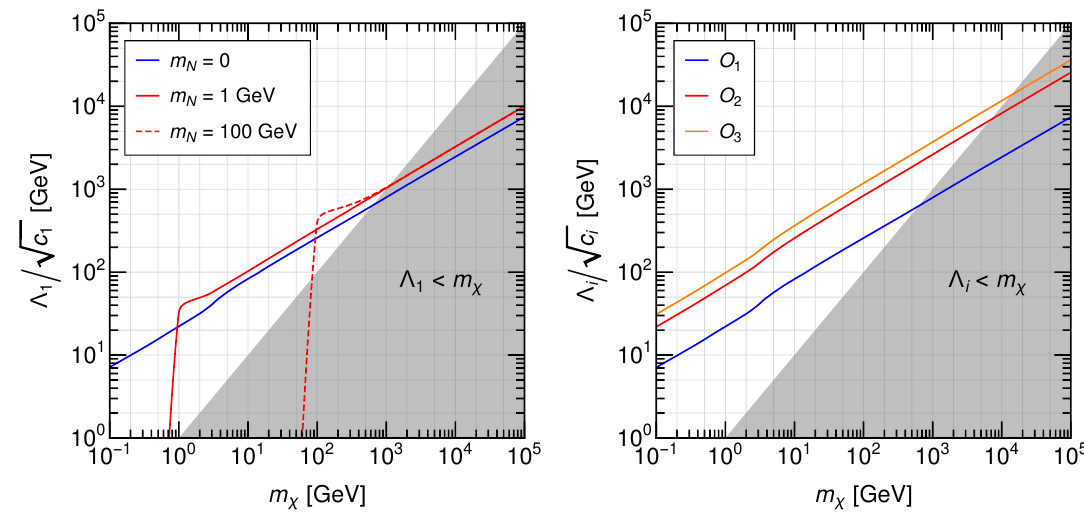
Figure 2 . New physics scales needed to obtain the observed relic abundance. Left) LNC operator, O 1 , for different values of the sterile neutrino mass. Right) All three sterile neutrino portal opera- tors, for m = 0 N